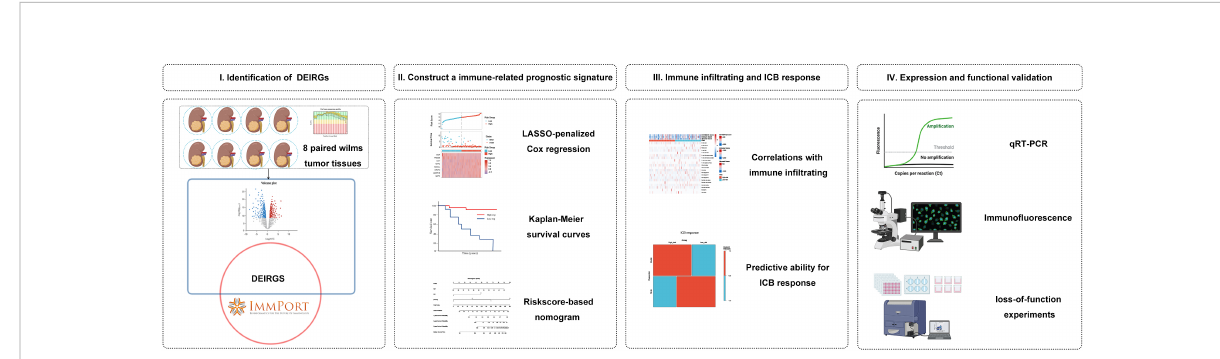
FIGURE 1 Analysis fl owchart. (I) Identi fi cation of differentially expressed immune-related genes (IRGs) by tumour tissue sequencing in Wilms tumour and the ImmPort database. (II) Construction and validation of immune-related gene signature in Wilms tumour. (III) Association with immune in fi ltration and predictive ability for the response to immunotherapy. (IV) Expression validation and functional